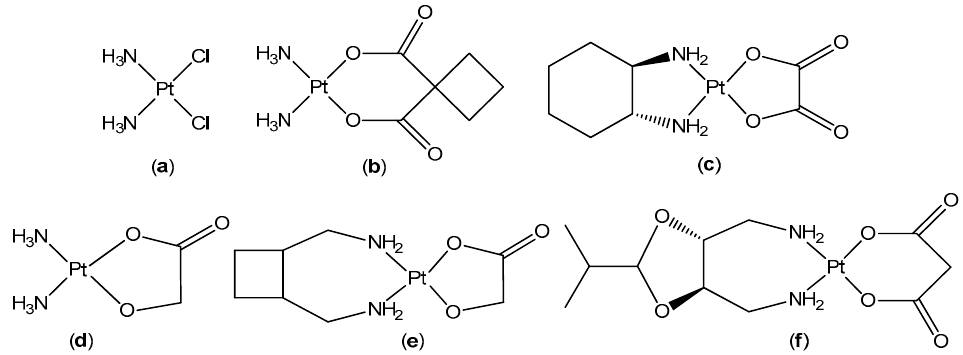
Figure 1. The chemical structures of: cisplatin ( a ); carboplatin ( b ); oxaliplatin ( c ); nedaplatin ( d ); lobaplatin ( e ); and heptaplatin ( f ).